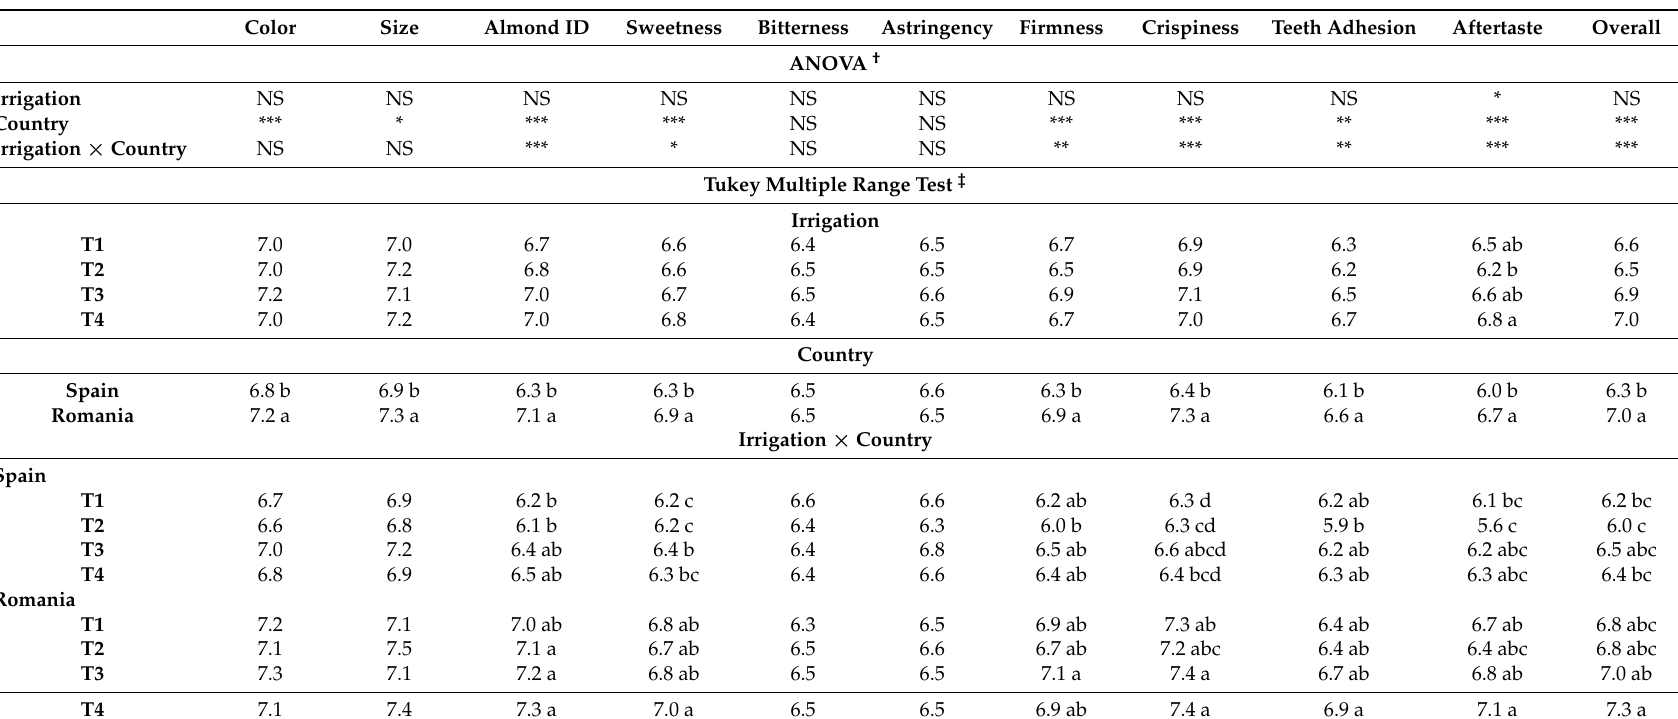
Table 3. Affective sensory analysis of raw almonds as affected by deficit irrigation and tested in two countries of Union Europe (Spain and Romania). Color Size Almond ID Sweetness Bitterness Astringency Firmness Crispiness Teeth Adhesion Aftertaste Overall ANOVA † Irrigation